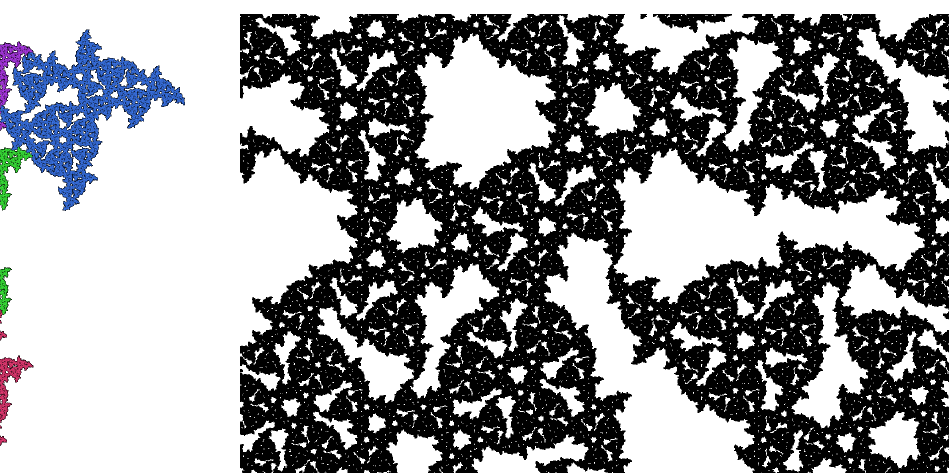
Figure 8. A carpet generated from irrational rotation by arctan 3 The expansion has determinant 7, so for m = 6 pieces we have dimension 1.84. There are 18 neighbor